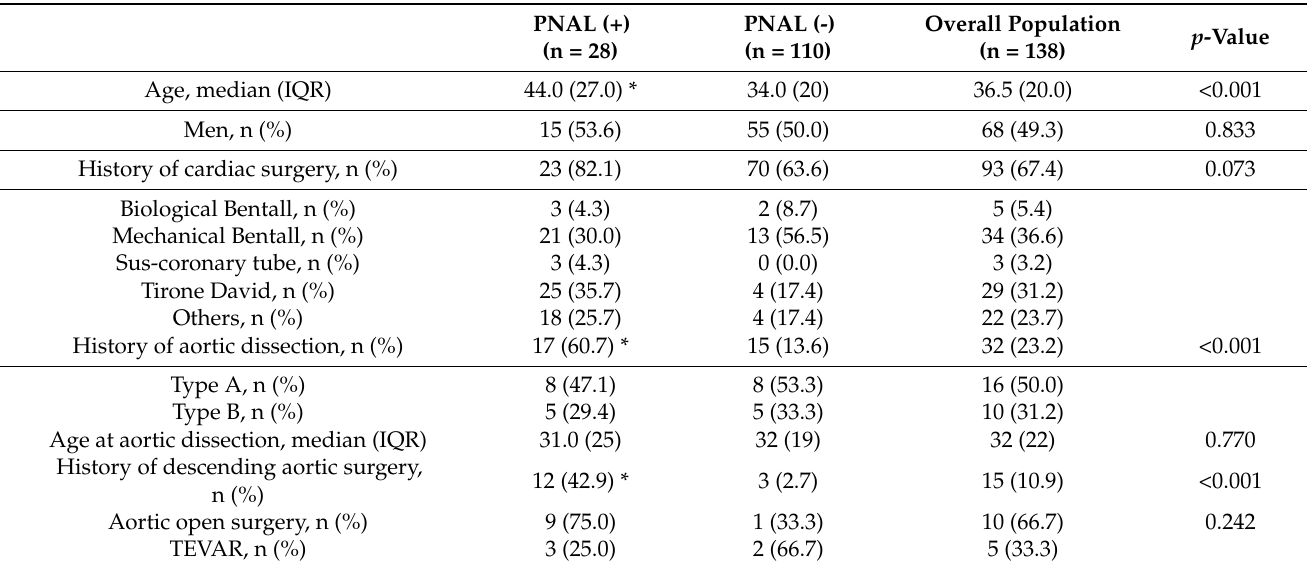
Table 1. Patients’ characteristics at baseline for those presenting with or without primary non-aortic lesions (PNAL (+) or PNAL (-), respectively).